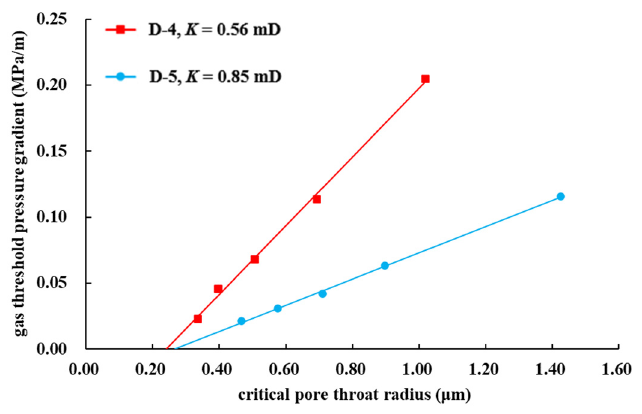
Figure 6. TPG versus critical pore throat radius.